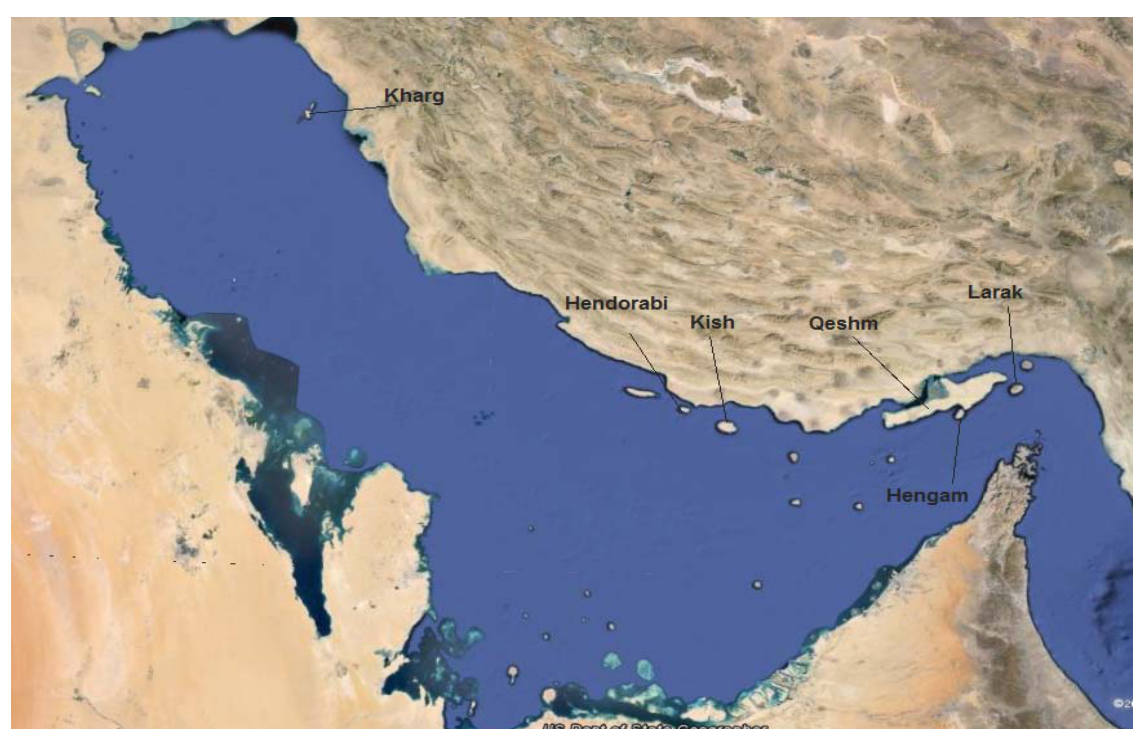
F IGURE 1. Map of sampling site in Persian